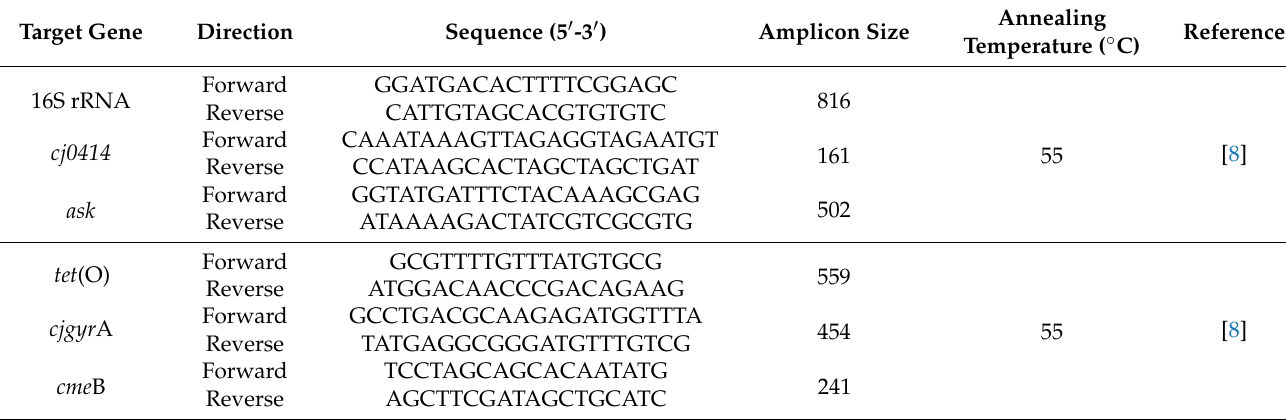
Table 1. Primers used for species and antimicrobial resistance